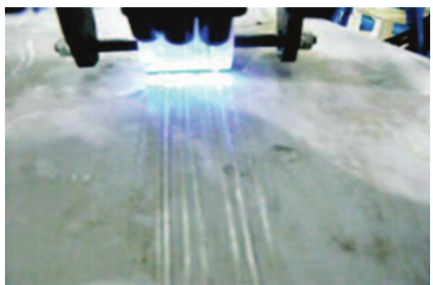
Figure 4: In situ UV curing manufacturing process